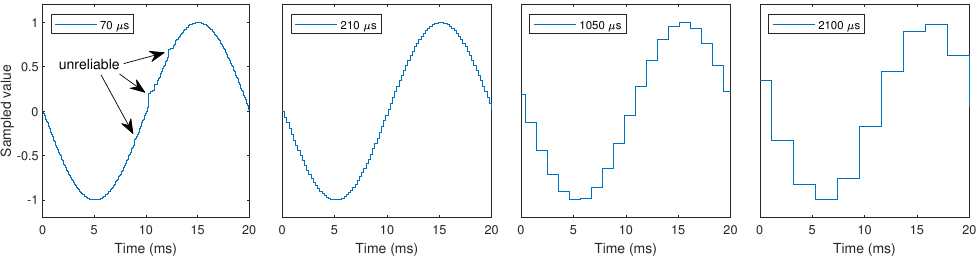
Figure 12. Reference sine wave visualization in the demo model at the controller sampling frequency (ARM sampling period of 70 µ s) and under-sampled by a factor of 3, 15, and 30 (ARM sampling period of 210 µ s, 1050 µ s, and 2100 µ s